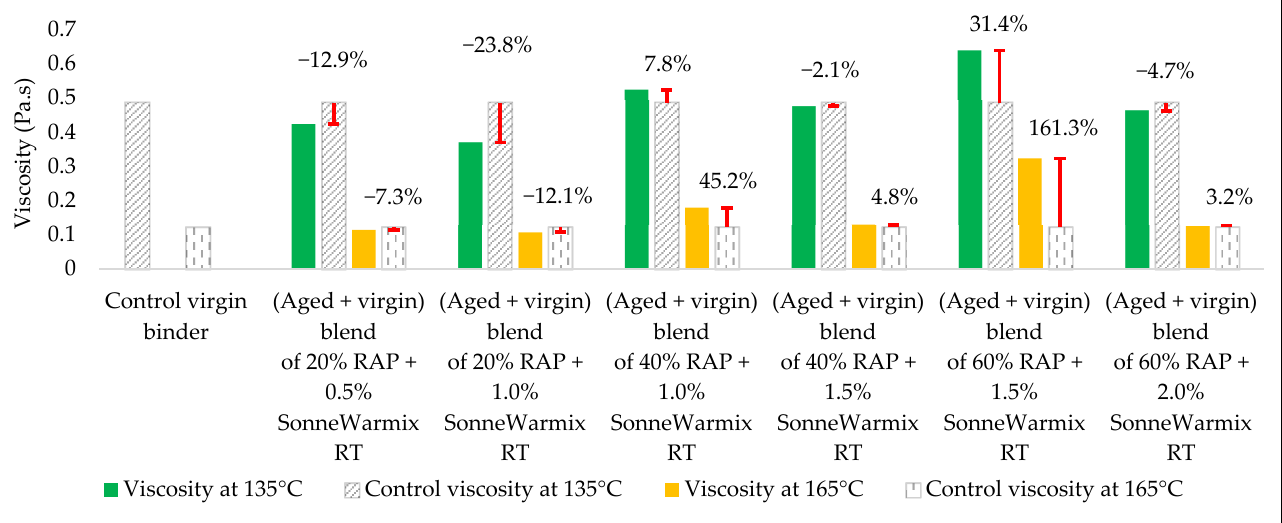
Figure 20. The change in viscosity level from adding SonneWarmix RT TM as a rejuvenator to the combined blend of binders in comparison to the control viscosity of the virgin binder.